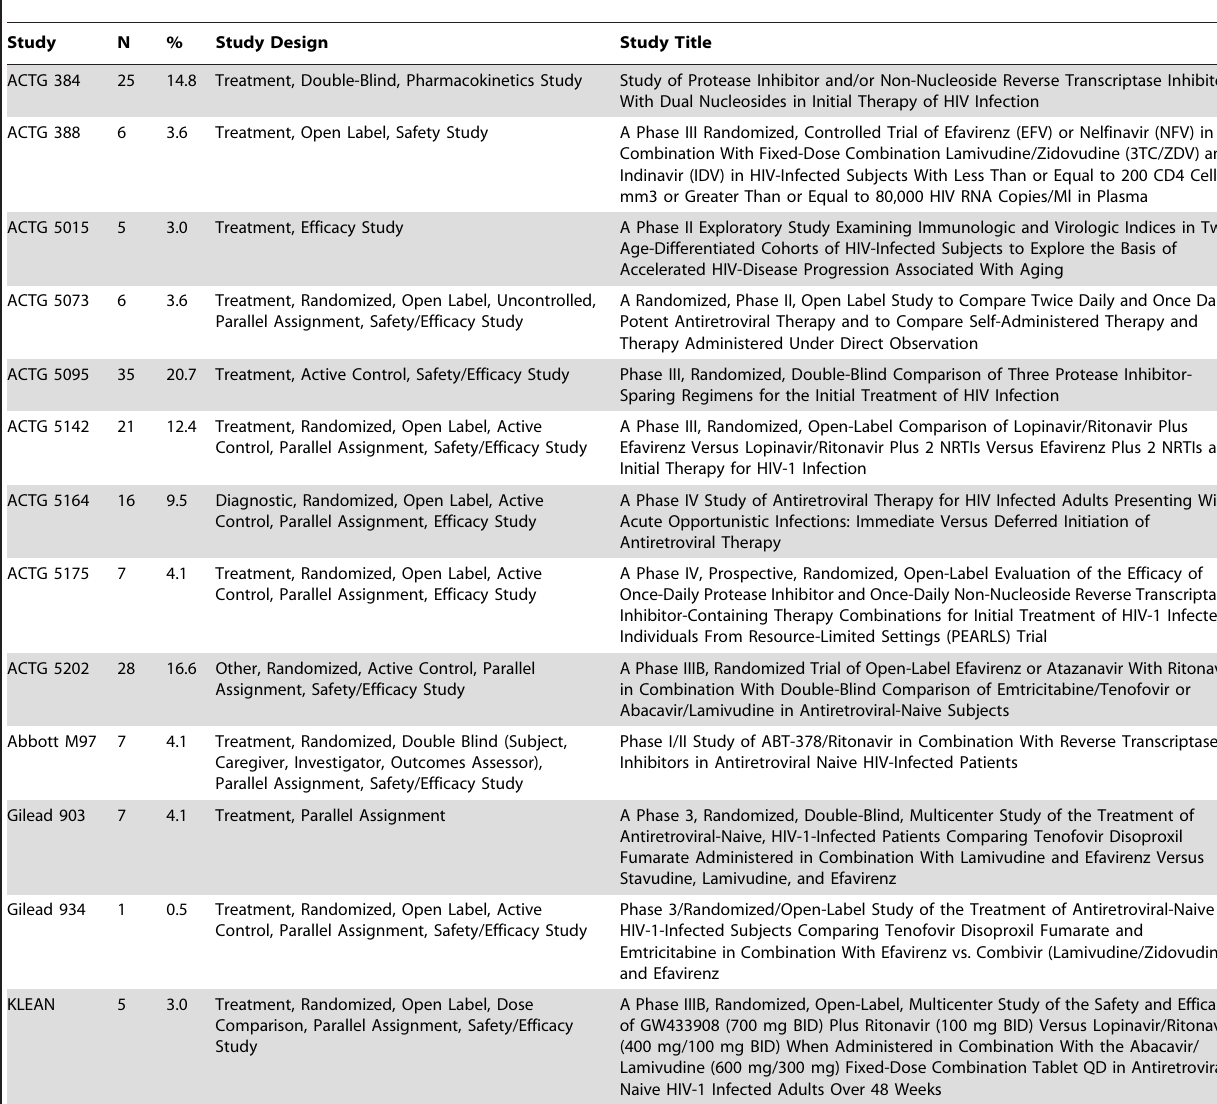
Table 2. Details of Clinical Trials included in this study: Number of Patients, Study Design and Study